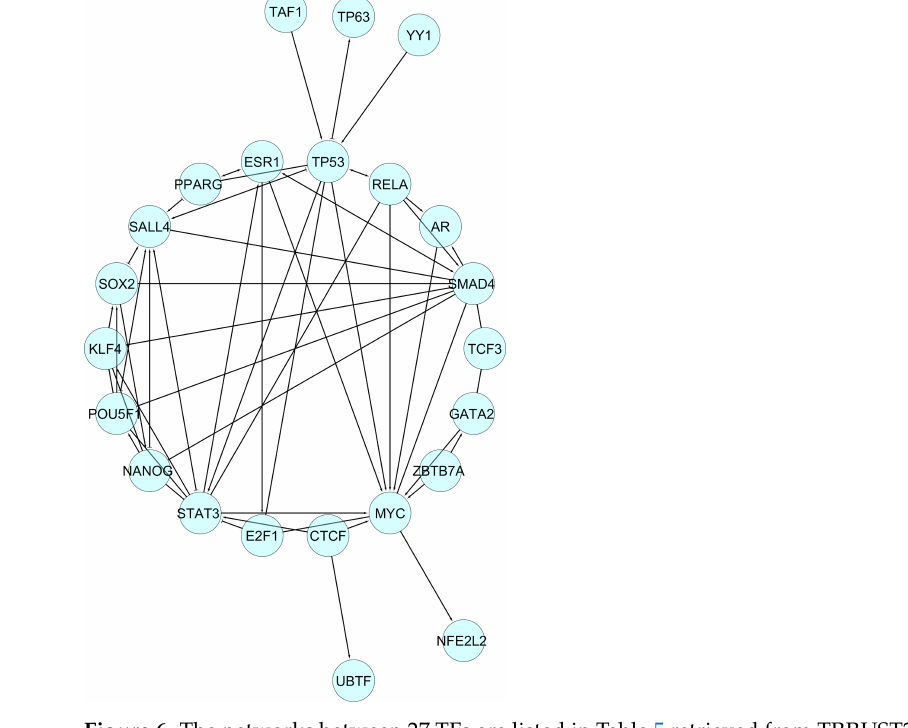
Figure 6. The networks between 27 TFs are listed in Table 5 retrieved from TRRUST2 [43]. Full infor- mation is available as Supplementary